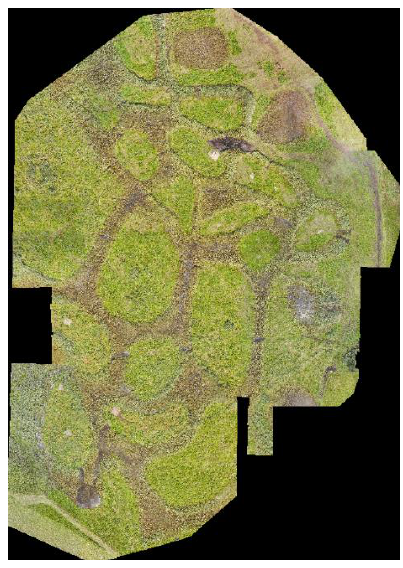
Figure 2 . Mosaic of the Pond Baroch obtained by UAV